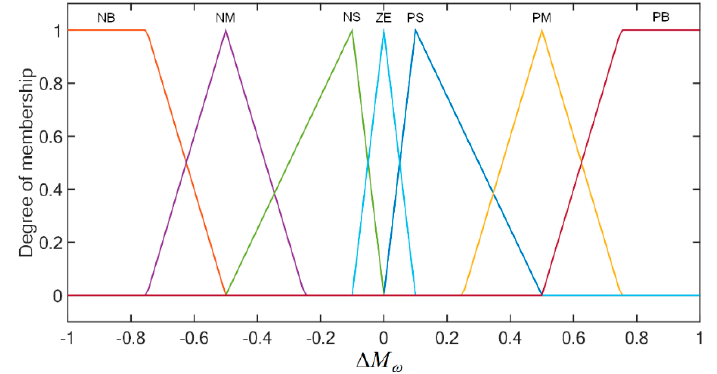
Figure 13. Membership function of Δ𝑀 (cid:3050) .